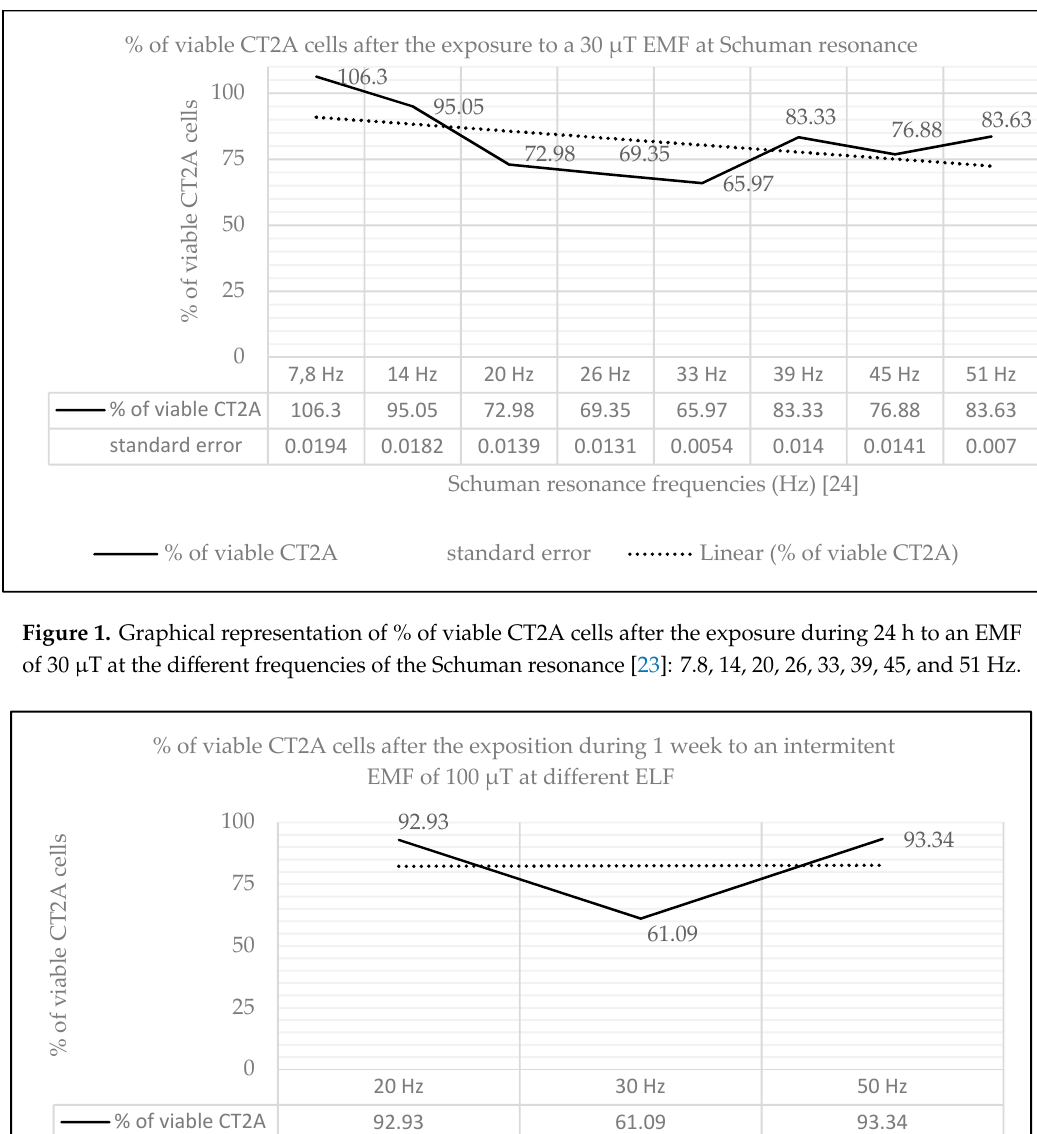
Figure 1. Graphical representation of % of viable CT2A cells after the exposure during 24 h to an EMF of 30 μ T at the different frequencies of the Schuman resonance [23]: 7.8, 14, 20, 26, 33, 39, 45, and 51 Hz.